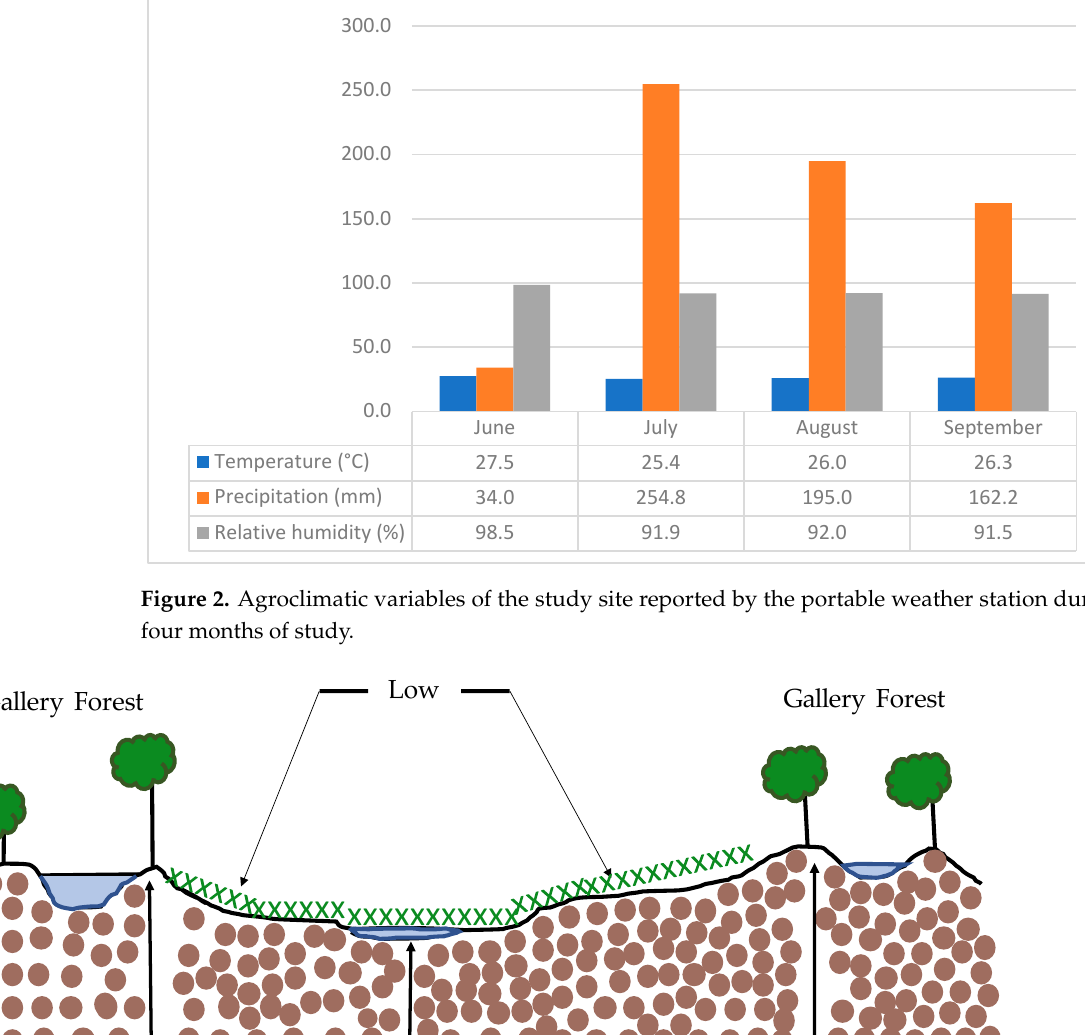
Figure 1. Department of Arauca in eastern Colombia. Circle: savannah floodplain agroecosystem, department of Arauca. Red color: location of the department of Arauca, eastern Colombia. Above photograph: savannah floodplain agroecosystem, eastern Colombia (latitude: 07° 08 ′ 17 ″ N, longi- tude: 70° 59 ′ 59 ″ W).